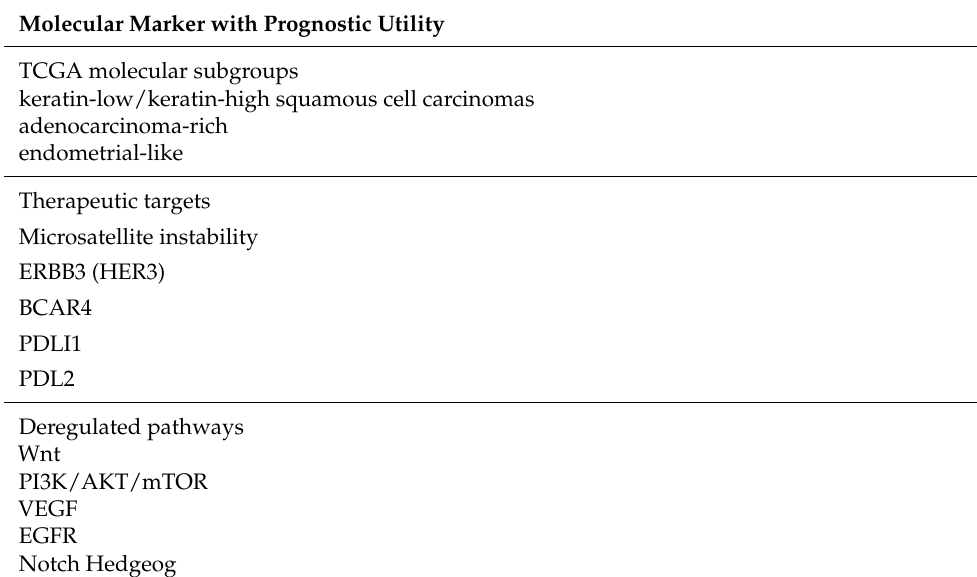
Table 4. Molecular prognostic